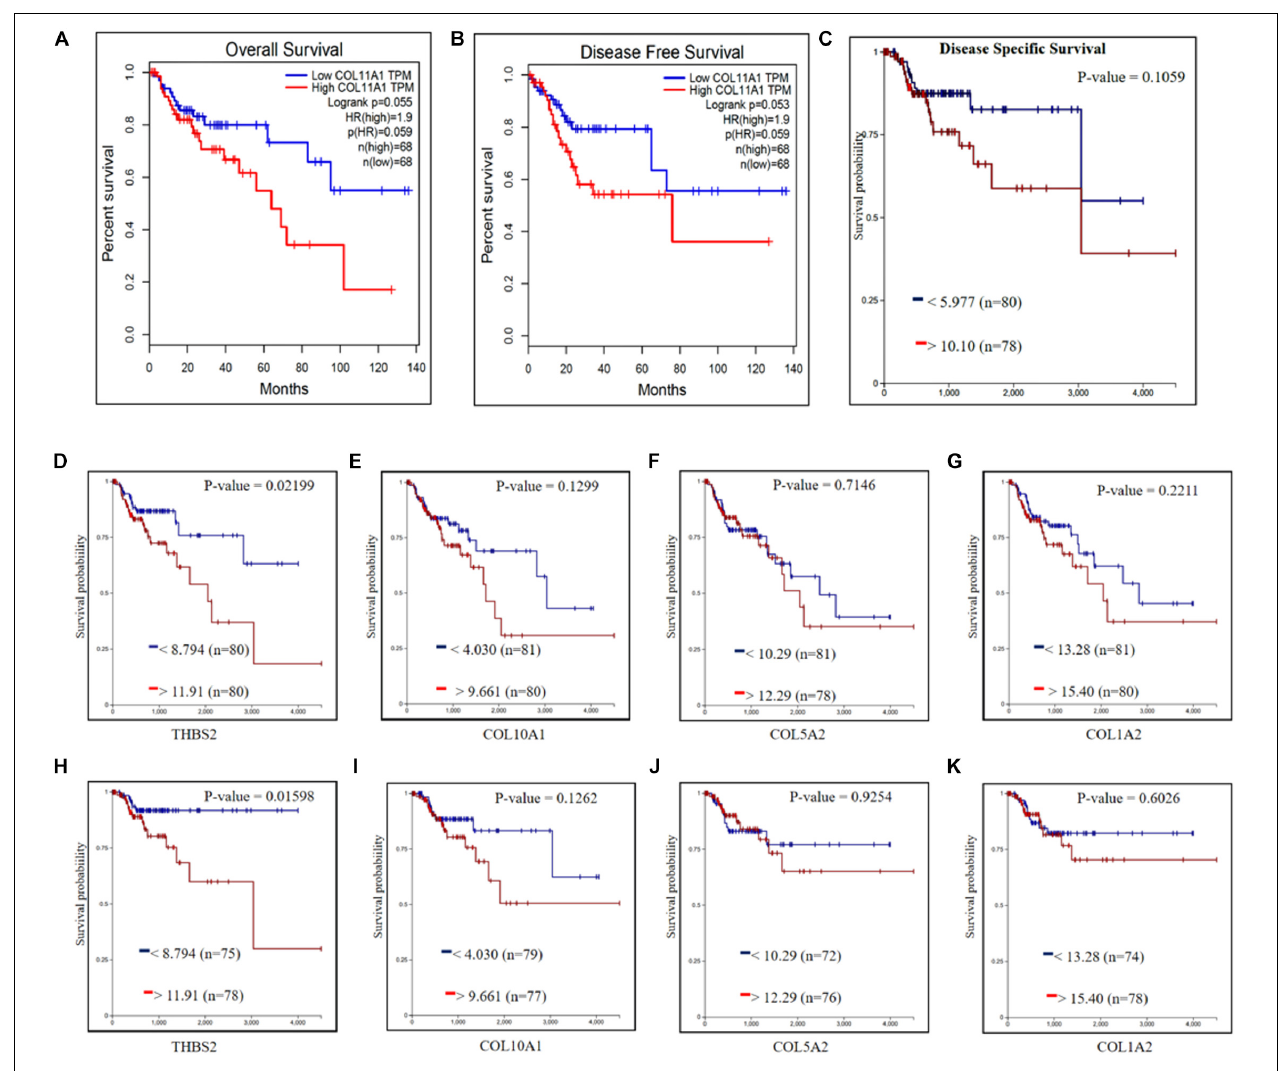
FIGURE 3 | KM-plot for survival assay of COL11A1 and other associated genes. (A–C) Effect of COL11A1 expression on (A) overall survival, (B) Disease-free, (C) Disease-specific survival. (D–G) Overall survival concerning gene expression of (D) THBS2, (E) COL10A1, (F) COL5A2, (G) COL1A2. (H–K) Disease-specific survival for the gene expression of (H) THBS2, (I) COL10A1, (J) COL5A2, (K) COL1A2. (Red and blue indicate the higher and lower expression of the gene,